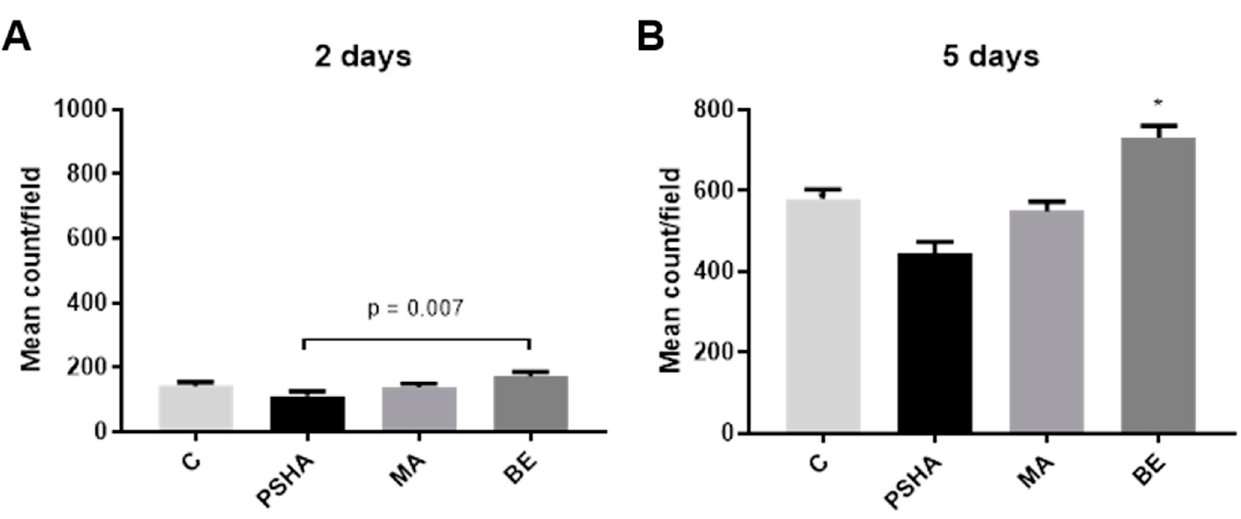
Figure 6. The counting of cells adhered to the surface through fluorescence showed that in 2 days ( A ) there was a significant difference only between the BE and PSHA groups with p = 0.007. On day 5 ( B ), the BE group had a significantly higher number of cells compared to the other groups (BE vs. C p = 0.0006; BE vs. PSHA p < 0.0001; BE vs. MA p < 0.0001), and the PSHA group had significantly lower cell counts than all the other groups (PSHA vs. C p = 0.003; PSHA vs. MA ( p = 0.028; PSHA vs. BE p < 0.0001). Bars indicate mean ± SEM of three independent tests with five biological replicates each. * Indicates significant difference from all other groups ( p <